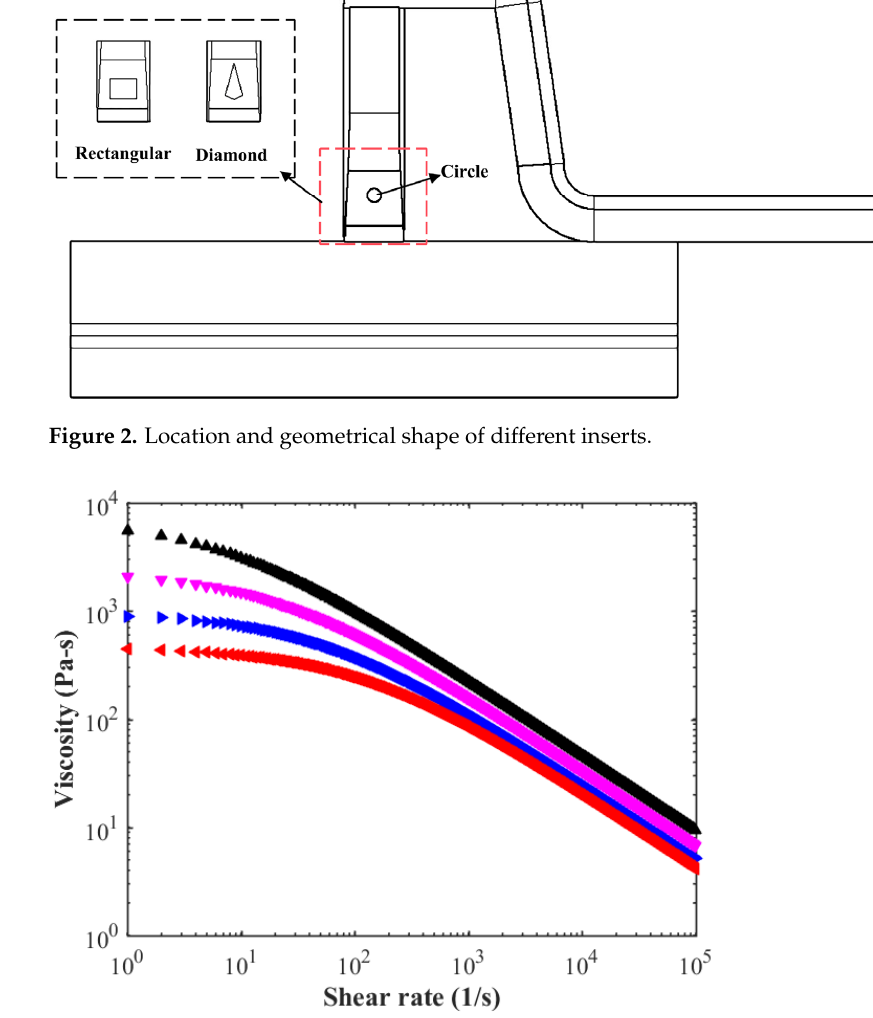
Figure 3. Viscosity curve of Cross-WLF model. Table 1. Parameters of Cross-WLF viscosity model for ABS.